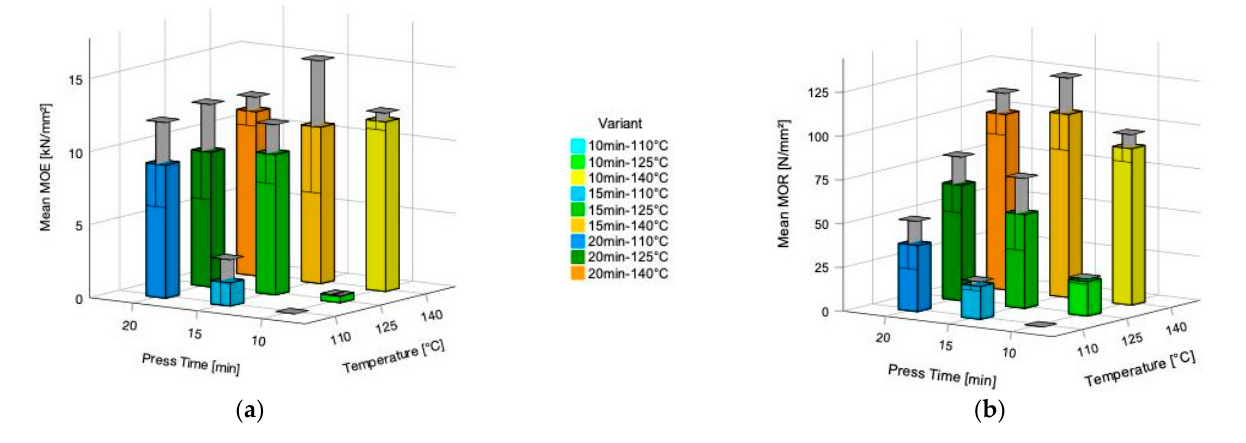
Figure 6. Influence of press time and press temperature of five layered Quebracho Tannin furfural bonded beech plywood on ( a ) Modulus of elasticity (MOE) and ( b ) Modulus of rupture (MOR). The top of the column indicates the means and the bars within the figure represent the standard deviation (SD).